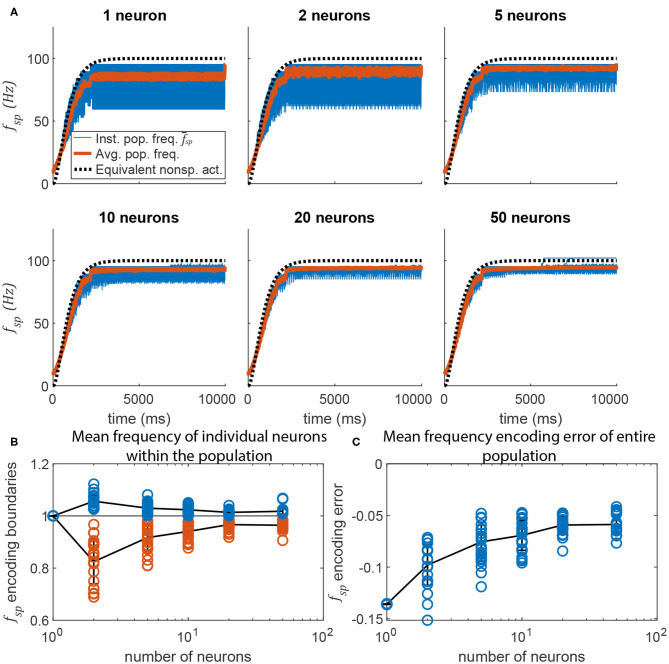
Adding more neurons to the pre-synaptic and post-synaptic populations increases encoding accuracy and reduces activation variation. (A) Average spiking frequency of the post-synaptic population f-sp over time when the spiking threshold θ is variable (i.e., m = −5) for all neurons. Thirty individual trials (blue), the mean over time (red), and the equivalent non-spiking pathway (black dotted) are plotted. (B) The highest (blue circles) and lowest (red circles) mean frequency of a single neuron in the population. Line plots the mean, error bars are ±1 standard deviation. (C) The error between the mean spiking frequency of the entire population and the intended spiking frequency for each trial is plotted (blue circles). Line plots the mean, error bars are ±1 standard deviation.